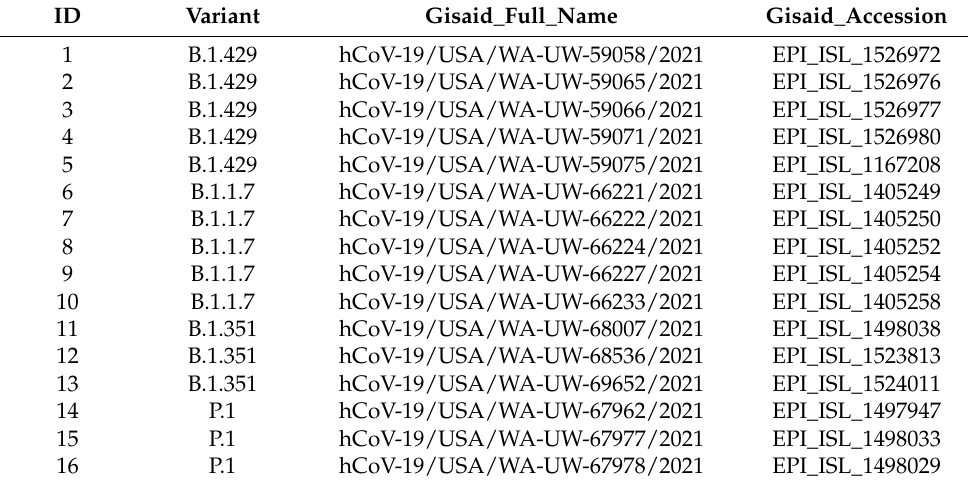
Table 1. SARS-CoV-2 Genomes used for Testing and